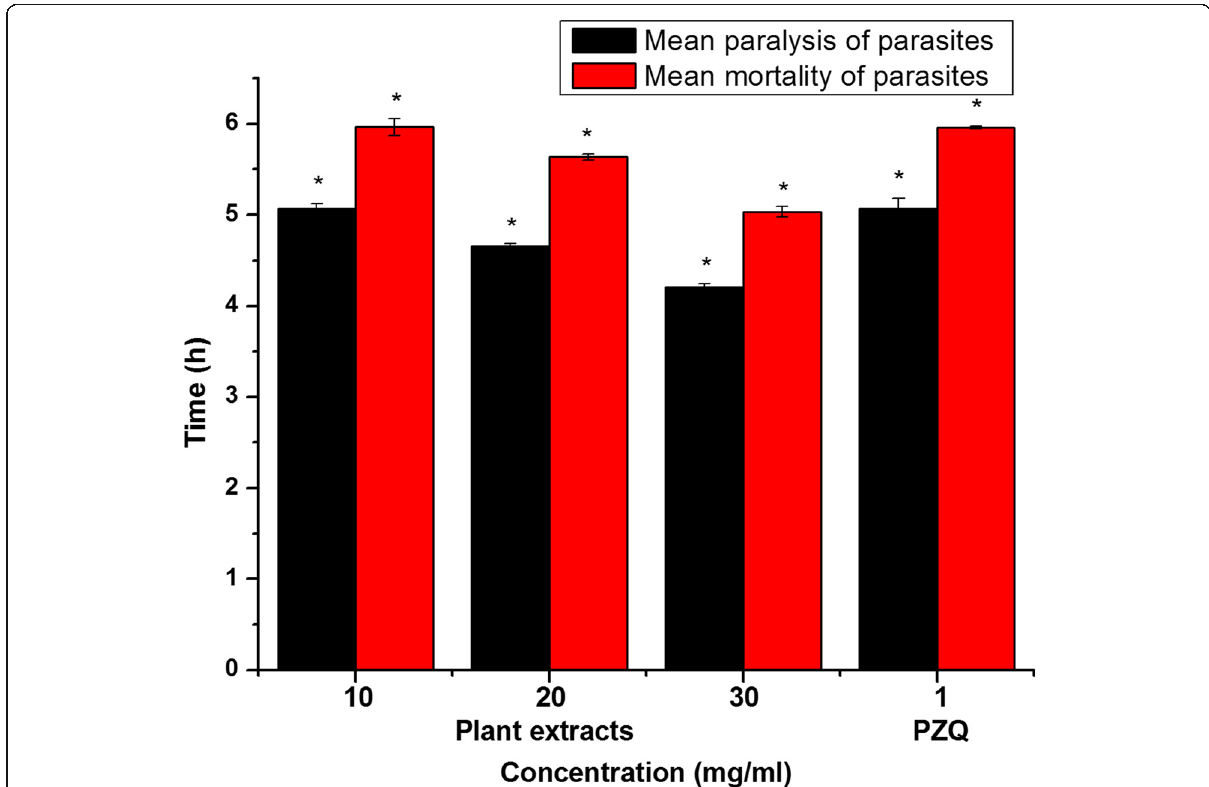
Fig. 2 In vitro anthelmintic effects of A. racemosus methanolic root extract against H. diminuta . Data is expressed as mean ± SEM. * p ˂ 0.0001 compared with control group, student ’ s t